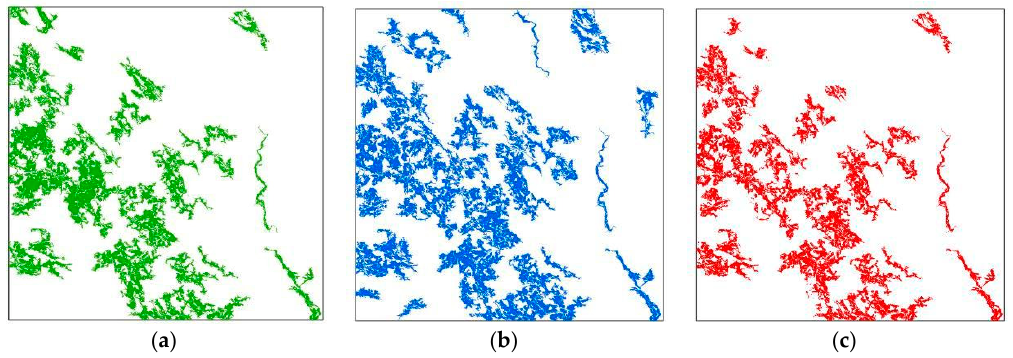
Figure 11. ( a ) Potential places of the deployment of DS—experts’ weights. ( b ) Potential places of the deployment of DS—theoreticians’ weights. ( c ) Common areas of potential places of the deployment of DS.